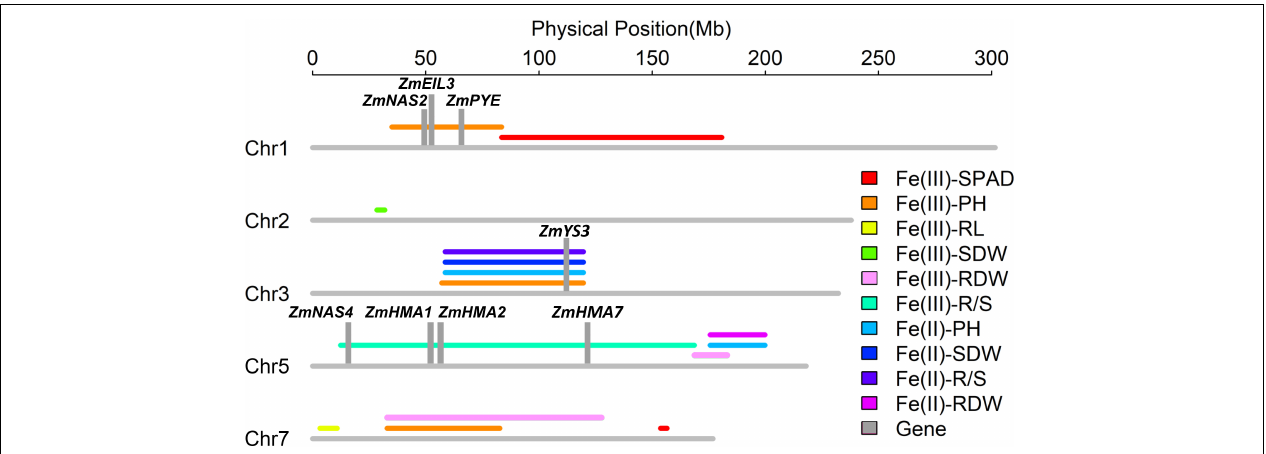
FIGURE 6 | Ten quantitative trait loci associated with Fe deficiency tolerance detected on Chromosomes 1, 2, 3, 5, and 7 in the Ye478 × Wu312 recombinant inbred line (RIL) population and the co-localizations identified in the same population on the supply of Fe(III)-EDTA (Xu et al., 2022). Important candidate genes ( ZmYS3